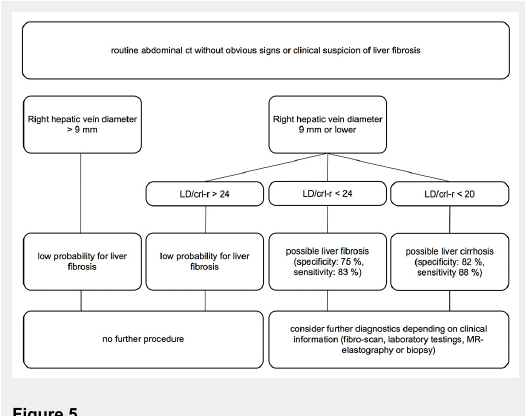
Possible work-up procedure for routine abdominal diagnostic examinations of patients without any suspicion of liver fibrosis. Increasing the right vein diameter threshold from 0.7 to 0.9 cm increased the sensitivity for fibrosis from 69% to 90% and prevented the exclusion of too many false-negative patients. ct = computed tomography; MR = magnetic resonance; crl-r = caudate-right lobe ratio; LD score = sum of liver vein diameters; LD/ crl-r = LD score divided by